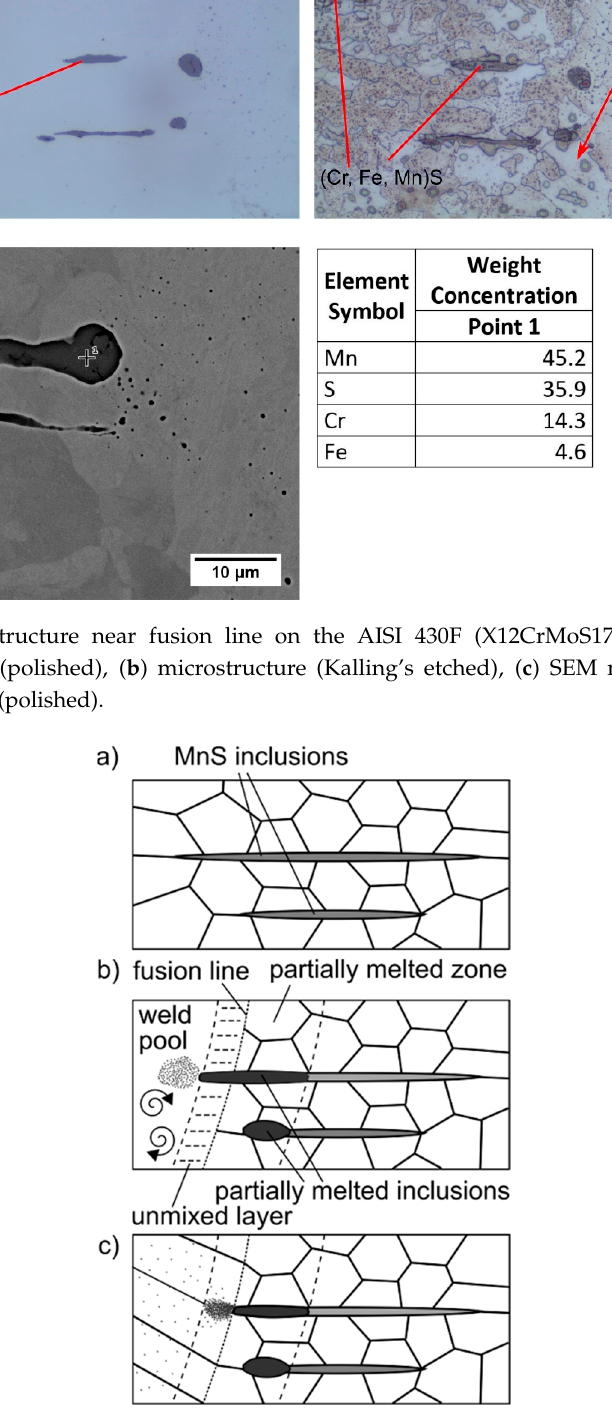
Figure 6. Constitutional liquation mechanism of sulfide in partially melted zone. ( a ) before welding; ( b ) during welding; ( c ) after welding.